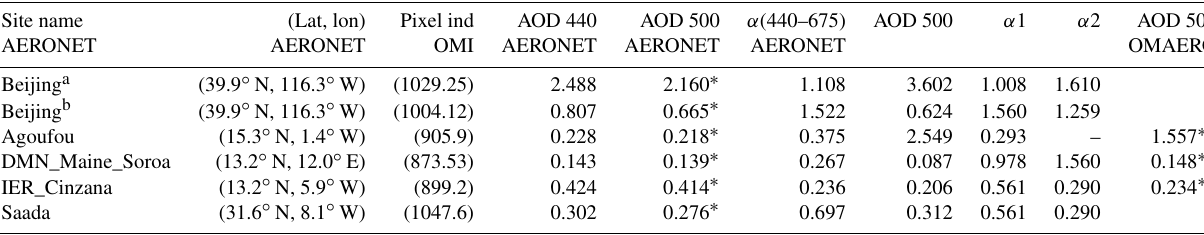
Table 2. The retrieved aerosol characteristics for AERONET sites and results from the presented method. The collocated OMI pixel indices in orbit are given in the column Pixel ind. The AERONET AOD at 440 and the Ångström exponent α (440–675)nm are daily averages of the data from level 2.0 version 2 direct-sun algorithm. We interpolated AERONET AOD at 500nm (marked by ∗ ) by Ångström power law using the instant values of α (440–675) and AOD at 440nm. The AOD at 500nm retrieved by the presented method is the MAP estimate from the averaged posterior density. The Ångström exponents α 1(442–500) and α 2(442–500)nm are calculated from the best-matching model LUT and from the second-best-matching model LUT, respectively. We interpolated OMAERO AOD at 500nm (marked by ∗∗ ) in the best-fitting LUT using AOD at